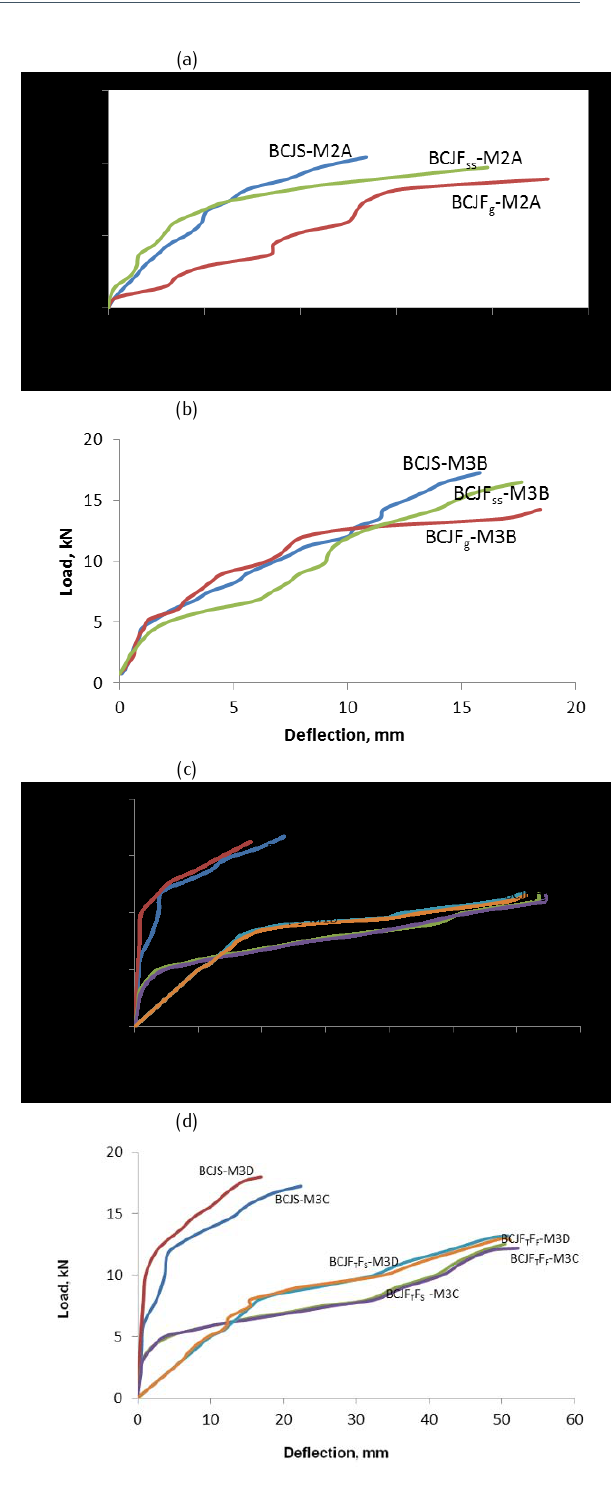
Figure 8. Load-deflection curves (a) A-series; (b) B-series; (c) C & D series for M1 grade & (d) C & D series for M3